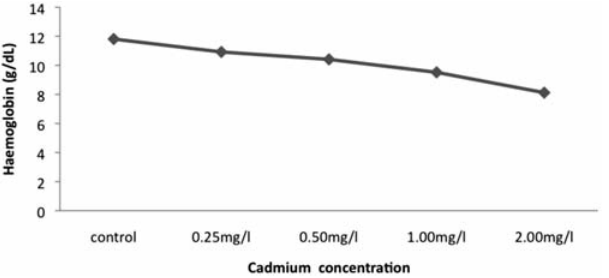
Figure 4. Variation in hemoglobin concentration in B. maculatus exposed to cadmi- um. Values are mean±standard deviation (n=9).